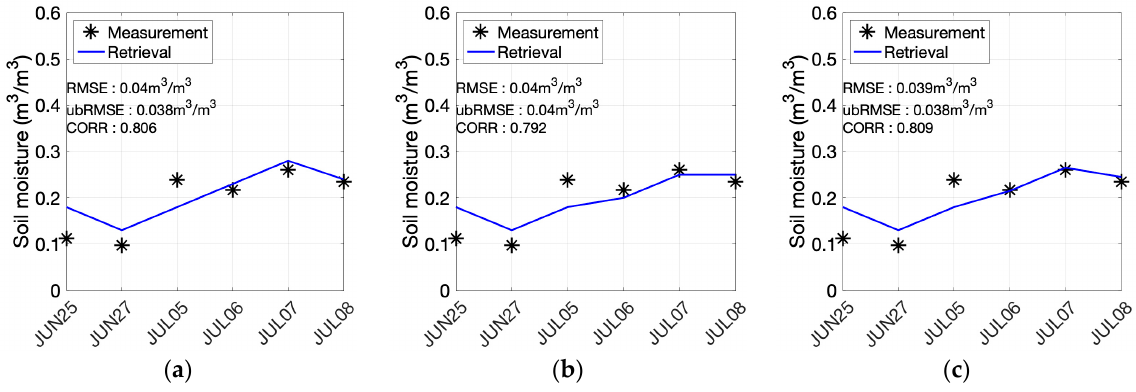
Figure 8. Soil moisture retrieval at soybean site 10 from ( a ) L-band ( b ) S-band ( c ) combined L- and S-bands.